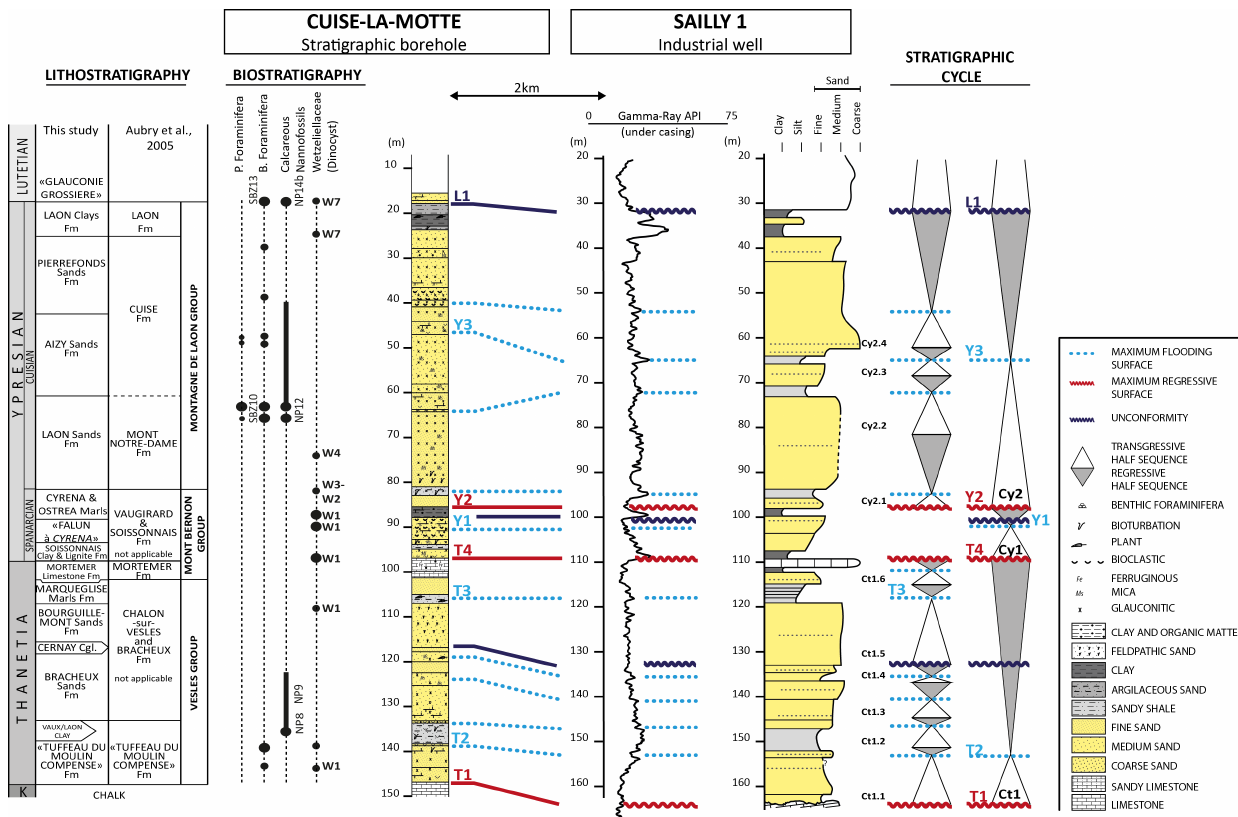
Figure 2. Stratigraphy and sedimentology of the most marine Palaeocene–Lower Eocene sediments of the Paris Basin: the Cuise-la-Motte stratigraphic borehole (Bolin et al., 1982) and the Sailly 1 well. The sequence stratigraphic interpretation is based on both the environmental changes along the Cuise-la-Motte borehole (palaeoecology and sedimentology) and on well-log correlations (see Fig.